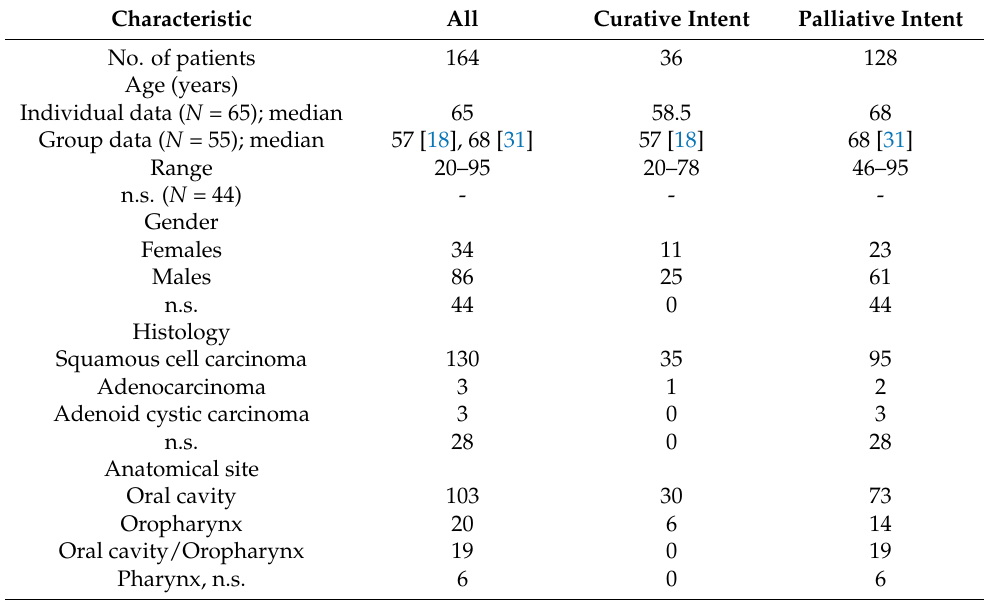
Table 2. Characteristics of the patients and